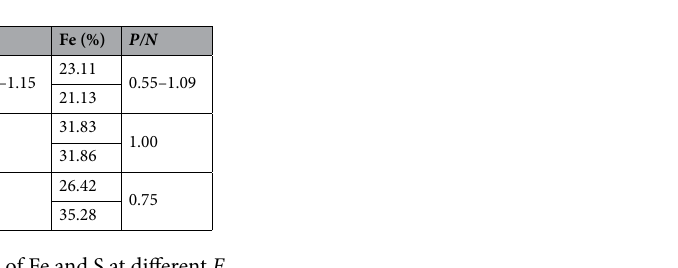
Table 1. P / N ratio and content of Fe and S at different E